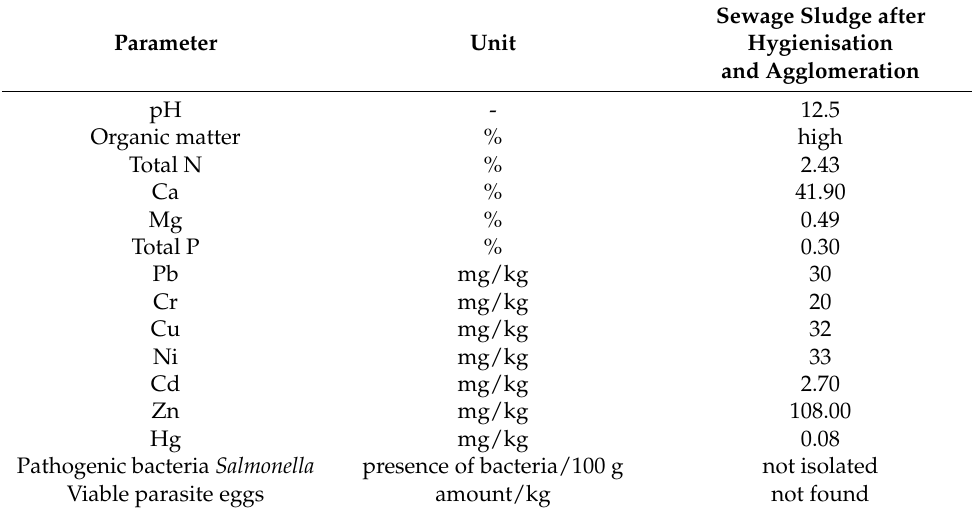
Table 1. The parameters of sewage sludge